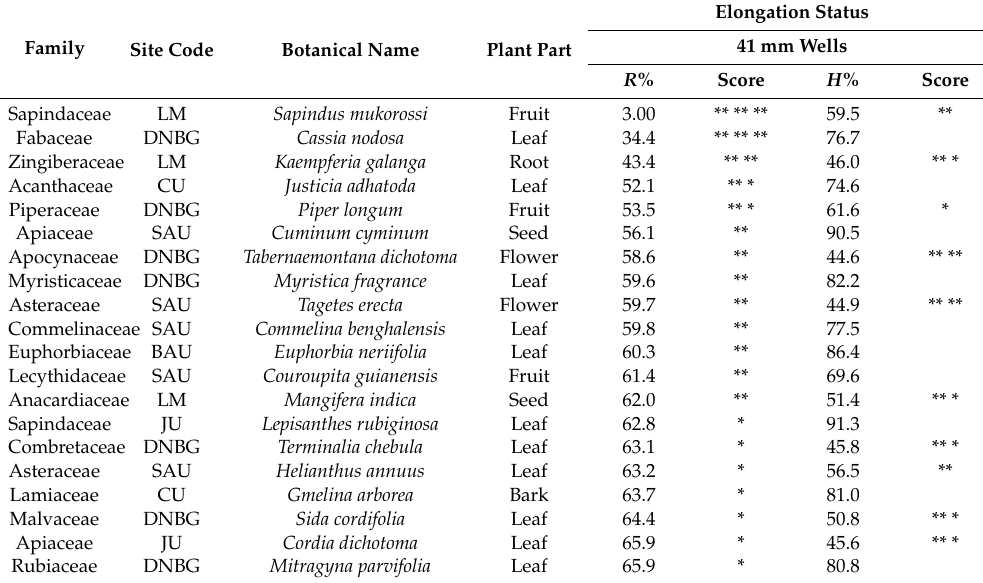
Table 2. The radicle and hypocotyl elongation (%) of L. sativa seedlings using the DP method (top 20